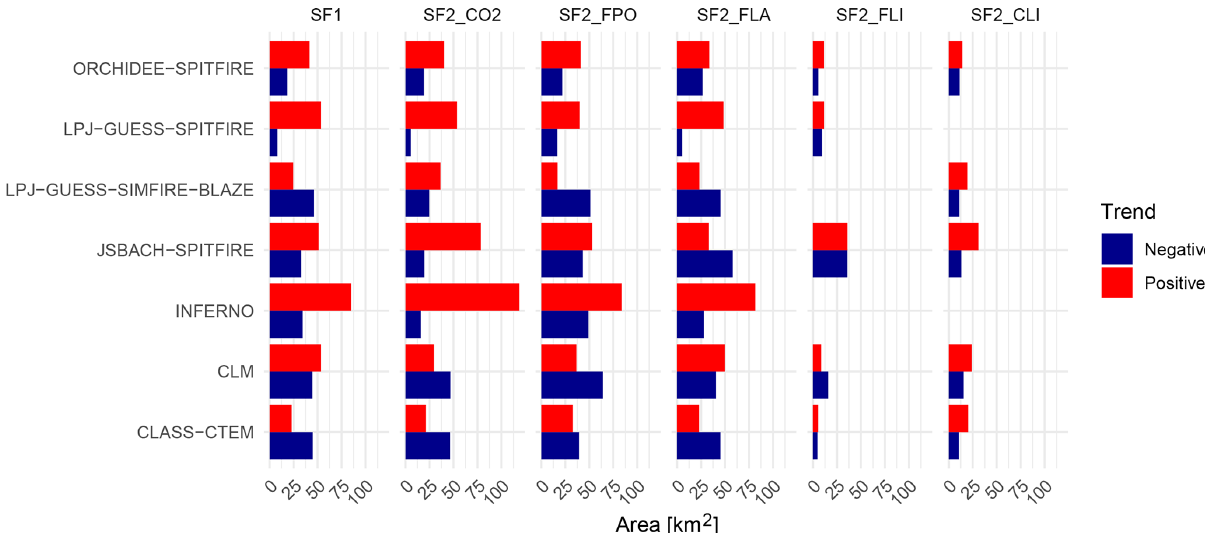
Figure 3. Area with a significant positive trend (red bar) or with a significant (Mann–Kendall test p < 0 . 05) negative trend (blue bar) in burned area fraction averaged over the years 1921–2013 for the baseline experiment SF1 and for the absolute differences in burned area fraction between the sensitivity experiments SF2 and SF1 (see Table 1). See Figs. A2–A7 for